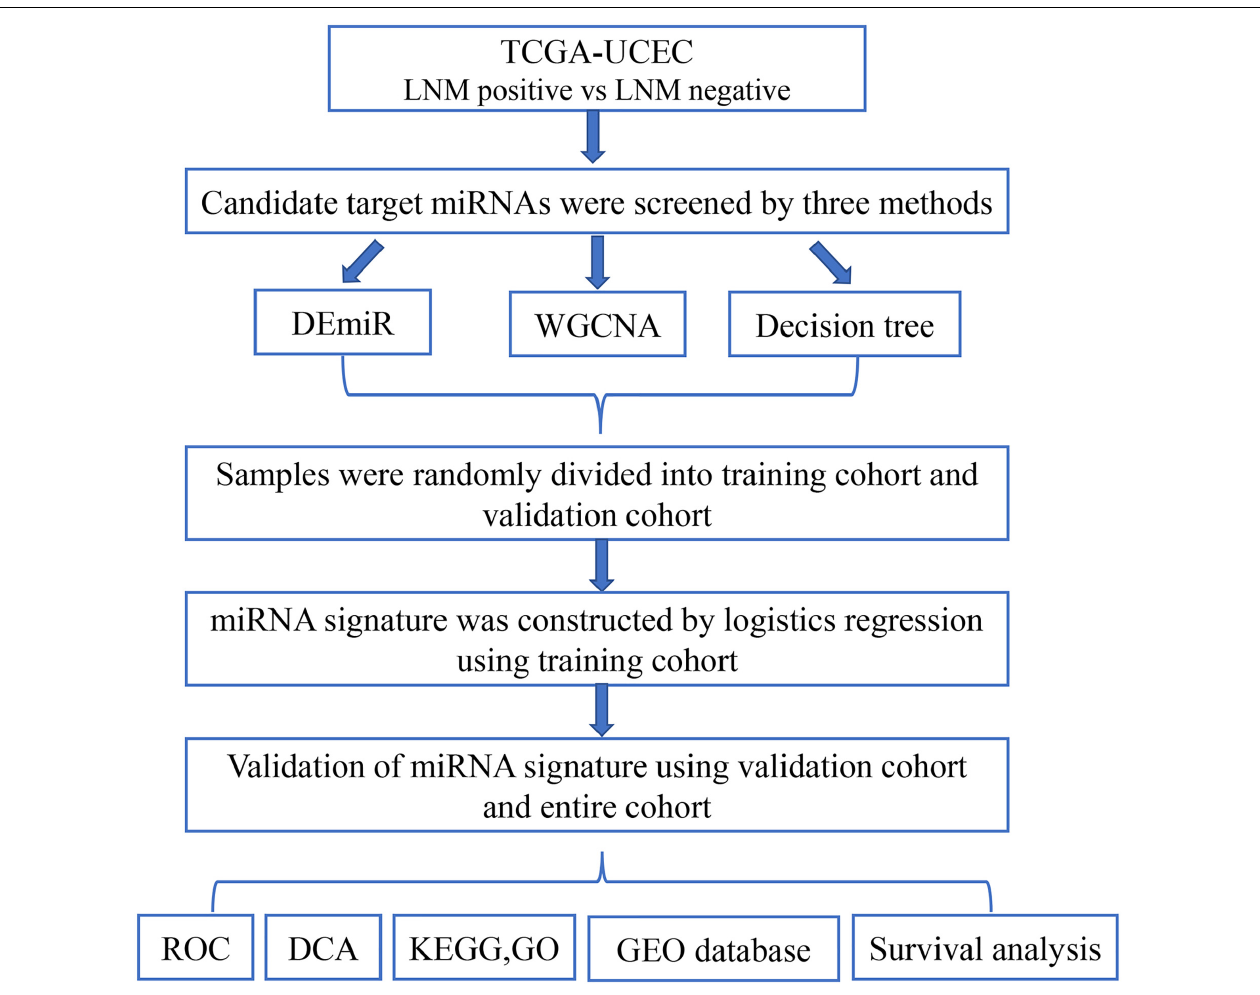
FIGURE 1 | Flowchart of the study. This figure describes the flow sheet of the study. LNM, lymph node metastasis; DEmiR, differentially expressed microRNA; WGCNA, weighted gene co-expression network analysis; ROC, receiver operating characteristic curve; DCA, decision curve analysis; GO, Gene Ontology; KEGG, Kyoto Encyclopedia of Genes and